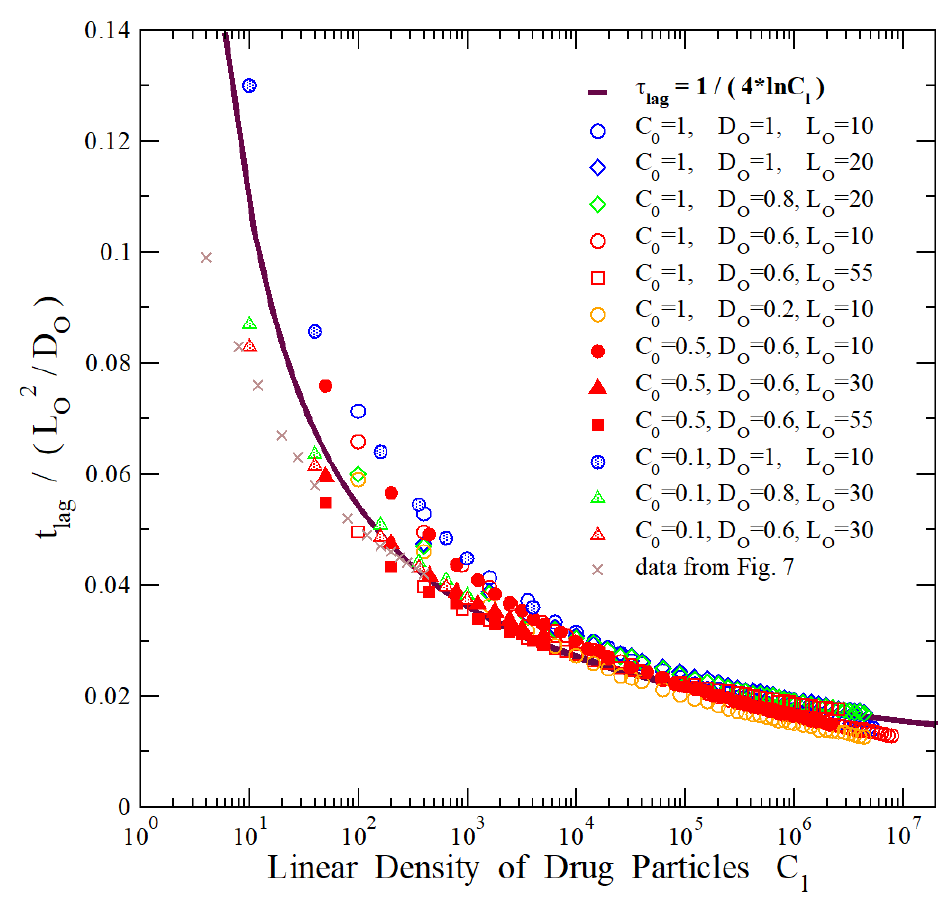
Figure 9. Dimensionless lag time t lag /(L O2 /D O ) as a function of the linear number density of initially loaded drug, C l = N 0 /L I . Symbols correspond to all numerical results derived through Monte Carlo simulations in this work. Continuous line depicts the analytical relation of Equation (5) with l u = 1 .